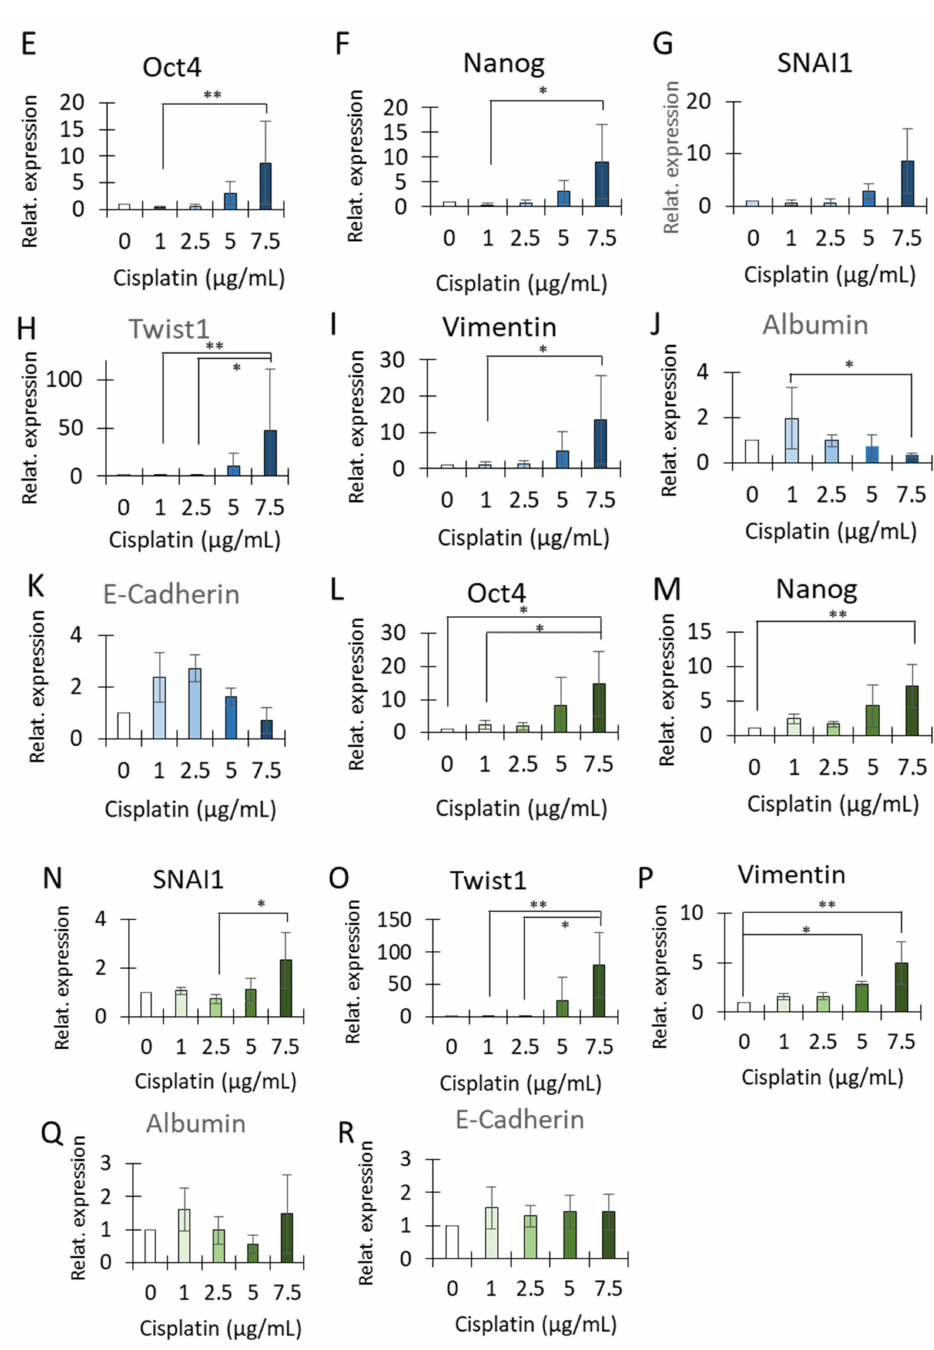
Figure 4. CD34+CD90+OV-6+csVimentin+ cells showed resistance toward Cisplatin, where the HepG2 and HuH6 cells were treated with 0, 1, 2.5, 5 and 7.5 µ g/mL Cisplatin. ( A , B ) After 72 h, cell viability was measured in an MTT assay. The values are the means, which are presented with error bars depicting the standard deviation from the mean. The assay was performed 4 times. Dunn’s multiple comparisons test was performed in order to calculate the significance of the data (* p < 0.05). ( C , D ) Resisting cells were measured for CD34 expression and OV-6 binding using flow cytometry. The values are the means, which are presented with error bars depicting the standard deviation from the mean. The measurement was done 9 times. Dunn’s multiple comparisons test was performed in order to calculate the significance of the data (* p < 0.05, ** p = 0.001–0.01, *** p = 0.0001–0.001, **** p < 0.0001). ( E – R ) Gene expressions of Oct4, Nanog, SNAI1, TWIST1, vimentin, albumin and E-cadherin were measured for Cisplatin-treated HepG2 ( E – K ) and HuH6 cells ( L – R ). The fold-change values of the untreated cells were normalized to 1 and the values of the treated cells were calculated in relation to the respective values. The columns represent the means with error bars depicting the standard deviation from the mean ( n = 4). Dunn’s multiple comparisons test was performed in order to calculate the significance of the data (* p < 0.05, ** p =